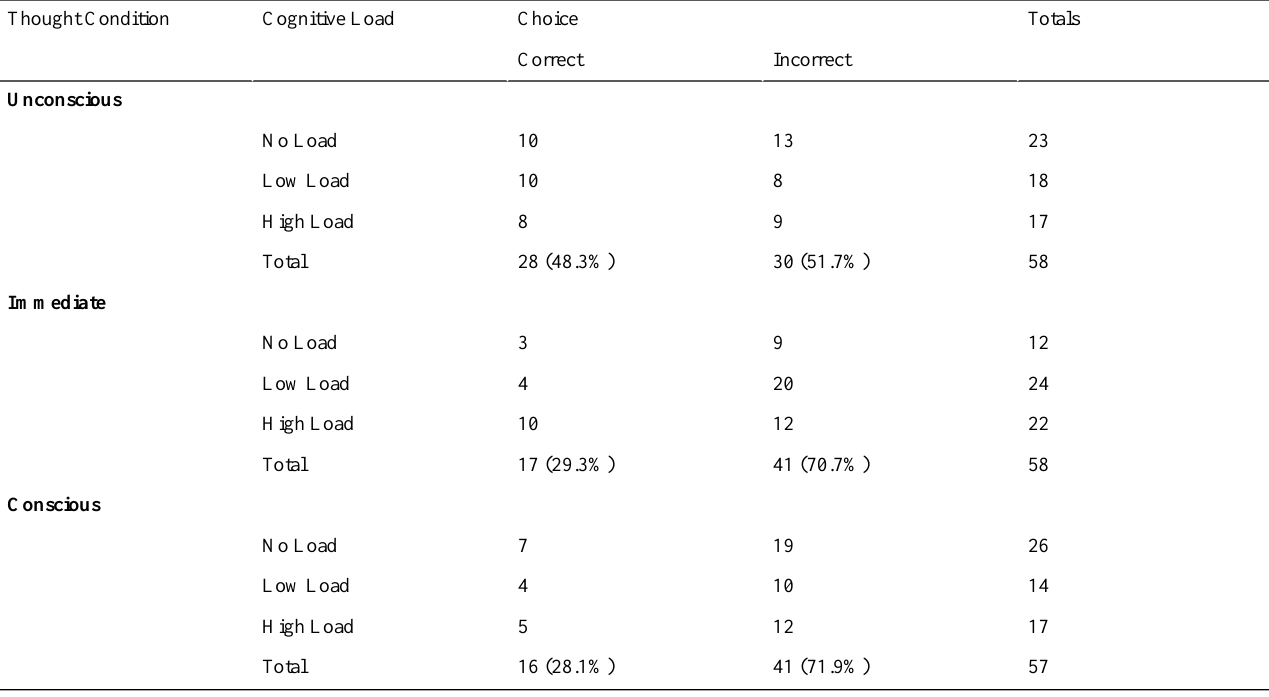
Table 1. Contingency table for choice broken down by thought condition and cognitive-load condition (n=173). TotalsChoiceCognitive LoadThought